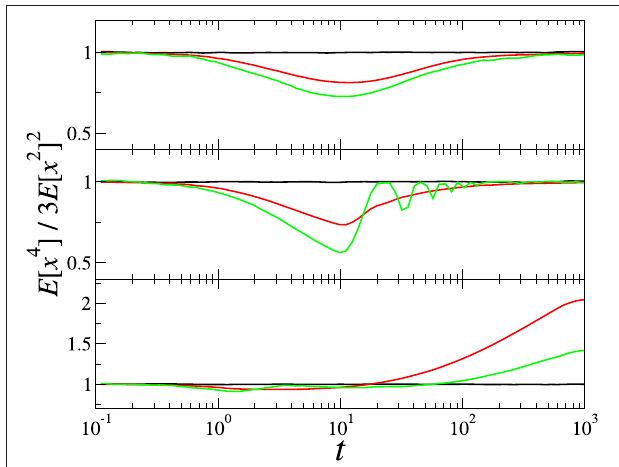
FIGURE 7 | The effect of P ( f ) on the gaussianity of the overdamped Langevin dynamics Equation (27). Three models of P ( f ) are the uniform distribution P ( f ) 1 / (2 √ 3) in [ −√ 3, √ 3] (red), the gaussian P ( f ) = (black), and the two-state P ( f ) Bottom, the panels show the non-gaussian parameters for the three models under the P ( τ ): poissonian (Top), gaussian (Middle), and the power-law (Bottom). The simulation parameters are same as in Figure 6 .